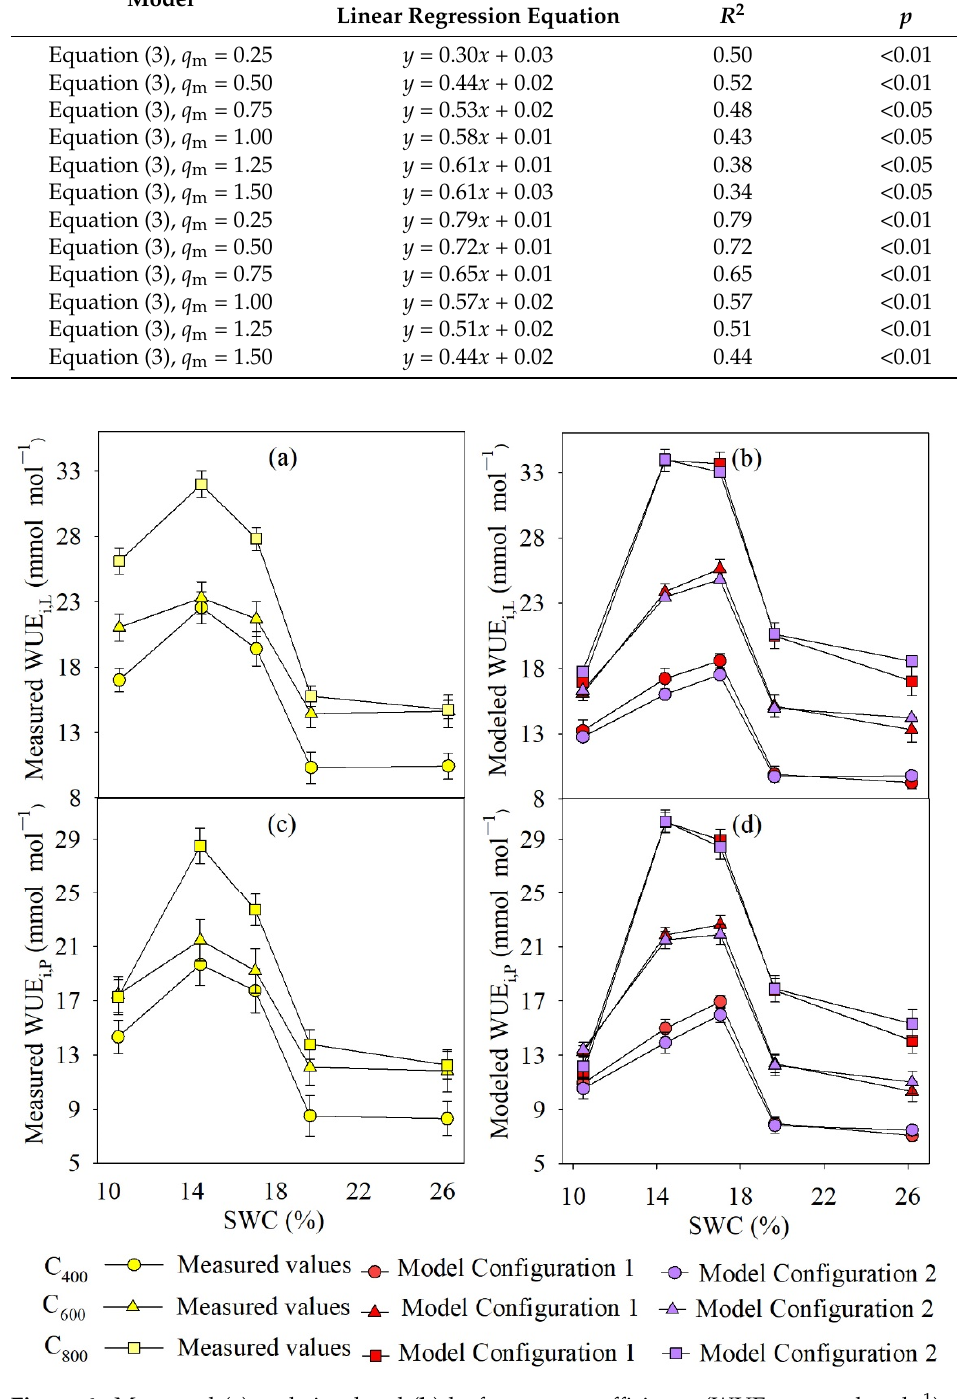
Figure 6. Measured ( a ) and simulated ( b ) leaf water use efficiency (WUE i-L , mmol·mol − 1 ), and measured ( c ) and simulated ( d ) whole-plant level instantaneous water use efficiency (WUE i-P , mmol·mol − 1 ) in different model configurations under five soil water contents (SWC) × three CO 2 concentrations ( C a ) conditions. C 400 , C 600 , and C 800 are C a of 400, 600, and 800 μ mol·mol − 1 . Data represent mean values ± SD.